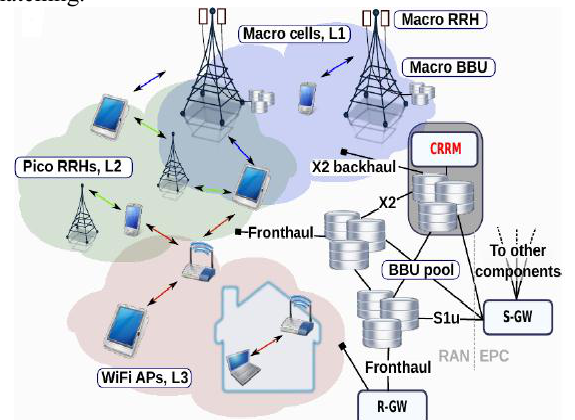
Figure 6. H-CRAN with licensed and unlicensed RAN [15] Bifurcated uplink resource allocation scheme is used for considered scenario which splits user traffic among available multiple radio interfaces. The resources are allocated on the basis of traffic, location of user and feasible RAN connectivity. The proposed scheme achieves high throughput and fairness due to cross-radio access technology (RAT) cooperation. For the feasibility of H-CRAN with cross-RAT coordination of the network, operator needs to aggregate the wi-fi access links and cellular link. Also users have to support more than one active radio interface at a